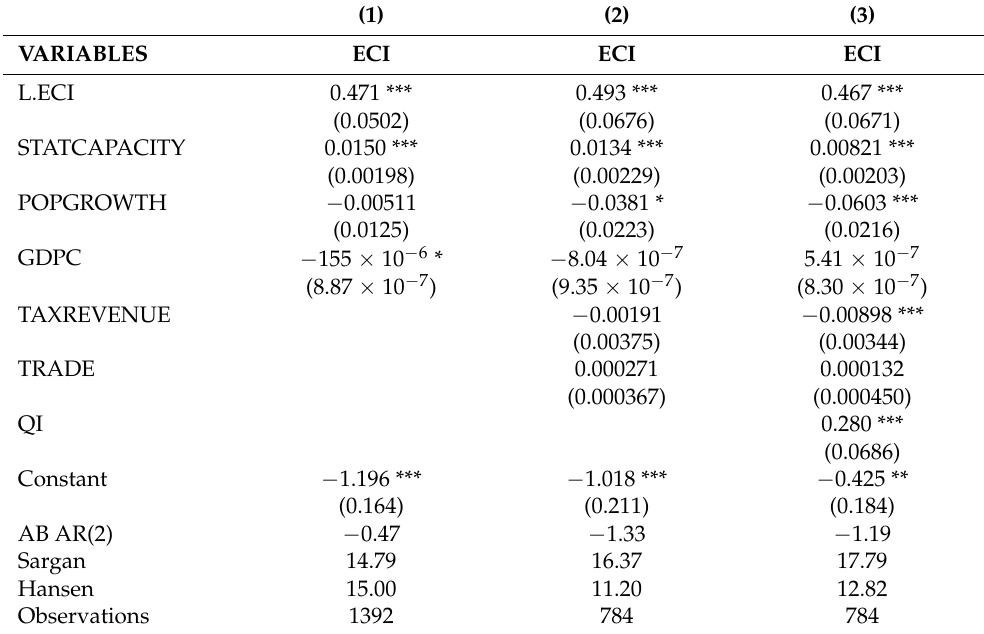
Table 4. Results of regression models (based on statistical capacity